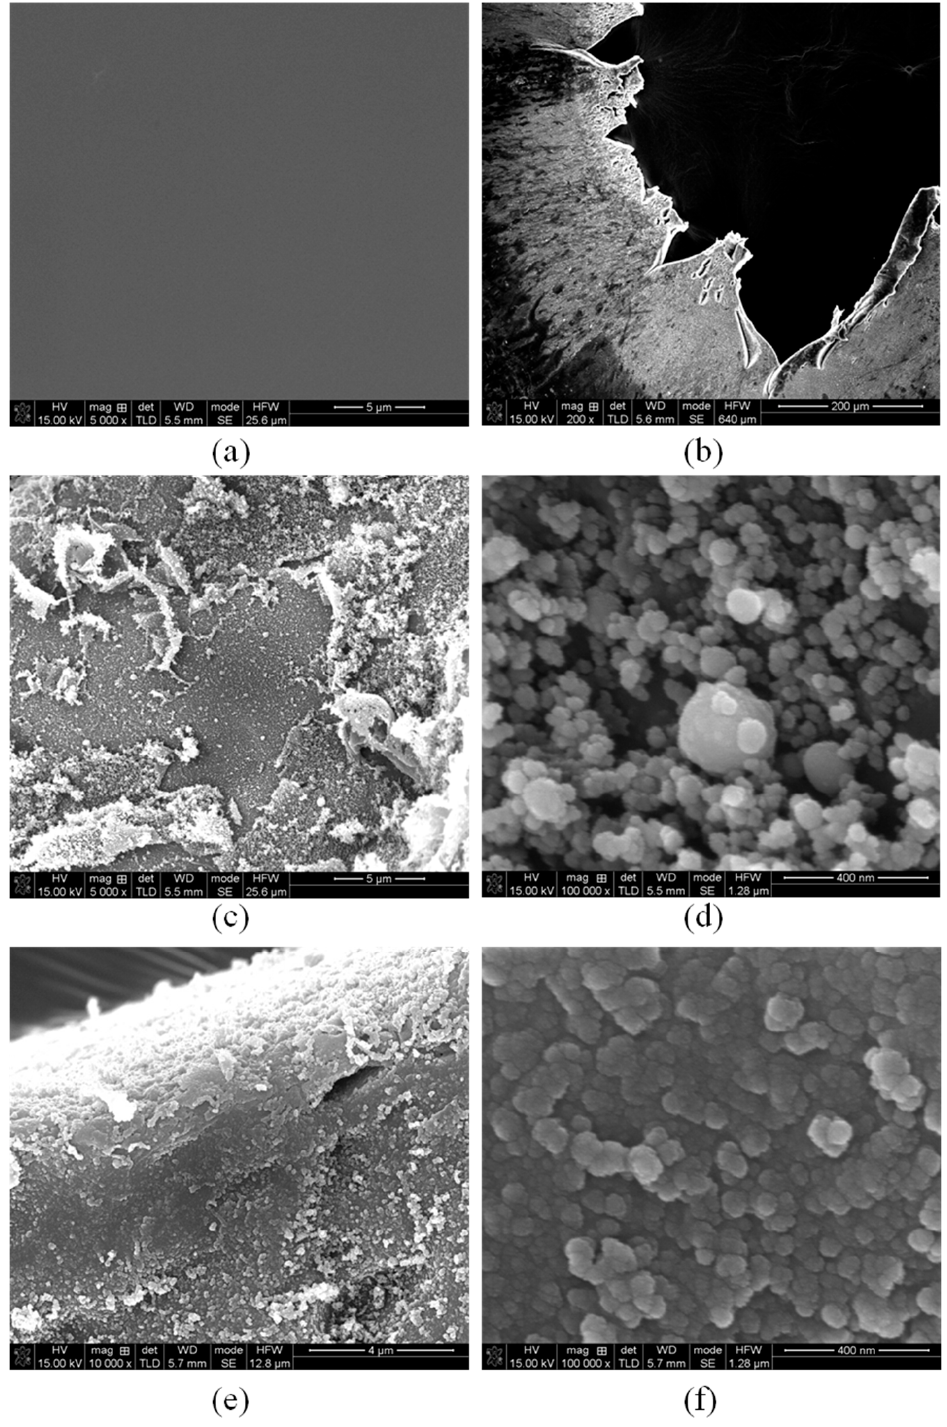
Figure 7. ( a ) SEM of the polyimide film flyer as prepared. ( b – f ) flyer plate after the electric explosion test. ( c ) and ( d ) display the morphology of the film surface attached to the ceramic substrate, ( e ) and ( f ) display the morphology of the film surface close to the barrel direction.